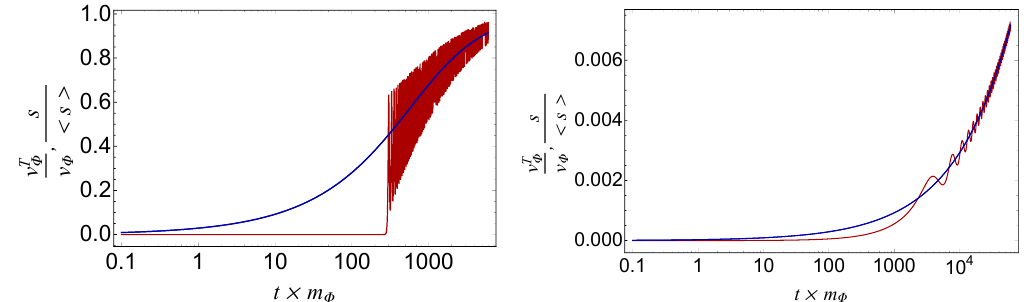
Figure 1 . The time dependence of s and v T around the 2nd order PT given in red and blue solid Φ lines, respectively. Effects of particle production and dissipation/decay are neglected. In the left panel we have taken m Φ = 0 . 1 GeV , v Φ = 10 14 GeV , and in the right panel m Φ = 0 . 1 GeV , v Φ = 10 8 GeV . We fix λ = λ 2 P